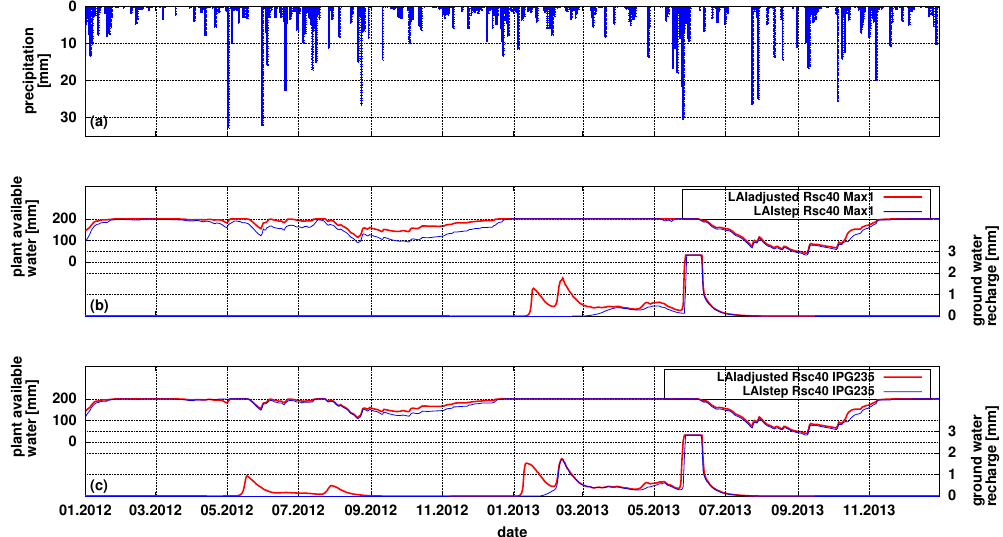
Figure 7. Measured daily precipitation (a) . Plant available water and ground water recharge as simulated for the step function and adjusted course for leaf area index and stomatal resistance, using the leaf unfolding (LU) parameters Max1 (b) and IPG235 (c) for simulating LU. The parameterisation for poplar is equal for 2012 and 2013, i.e. the same vegetation hydrological modelled driven by different weather conditions, i.e. a drier year 2012 with an earlier dry period in